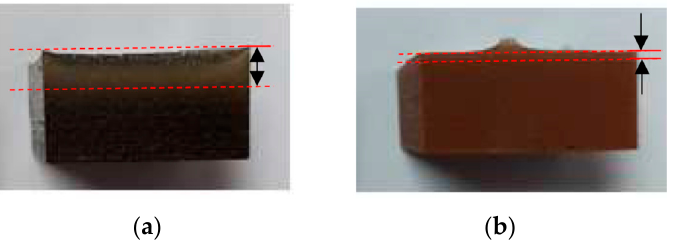
Figure 4. Filler sedimentation occurring at sample brass and copper: ( a ) brass filler; ( b ) copper filler.